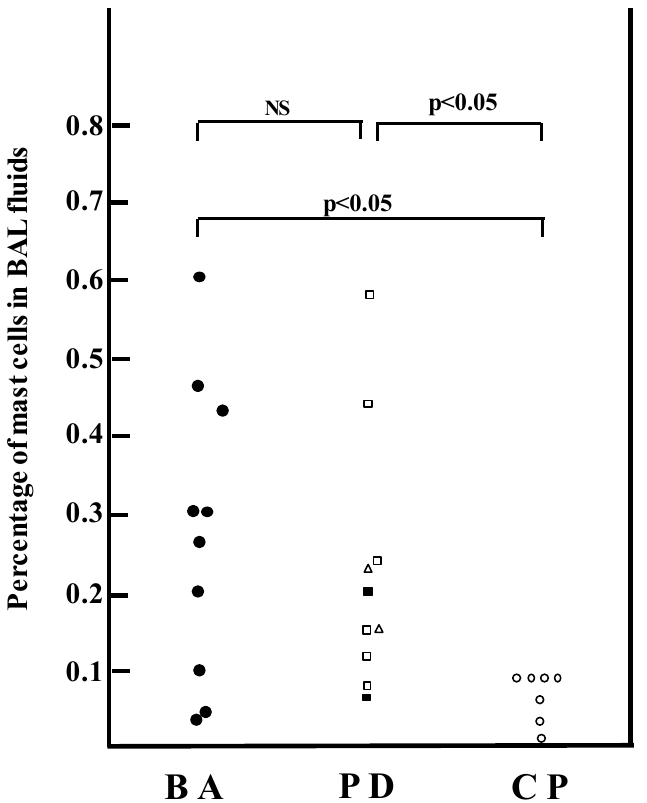
Figure 1. Percentage of mast cells in BAL fluids in asthmatics (BA: ● ), patients with other pulmonary diseases (PD): interstitial pneumonia ( □ ), sarcoidosis ( △ ), and chronic obstructive pulmonary diseases ( ■ ), and control patients (CP: ○ ). (Bars indicate SEM). The figure was modified from reference [11] with permission: Tomioka et al., Mast cells in bronchoalveolar lumen of patients with